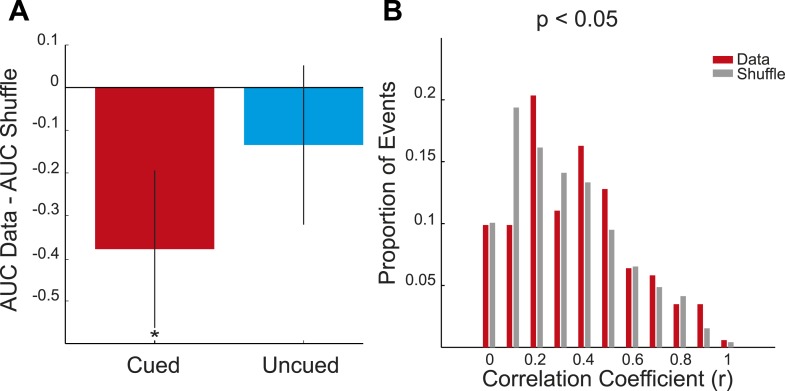
Preplay of cued arm during GOAL-CUE—distribution-based analysis A mean difference between the cumulative distributions of absolute correlations for the bootstrapped data and shuffle for the cued and uncued arms during GOAL-CUE.If a place cell template is preplayed then AUC of the data distribution should be smaller than that of the shuffled distribution (i.e., negative difference score). To assess significance we computed 95% confidence intervals for the difference scores. If the confidence interval did not contain 0 we deemed the data distribution to be significantly different from the shuffle distribution. The distribution for the cued arm was found to be significantly different from the shuffle (p = 0.02), yet that of the uncued arm was not (uncued p = 0.24). Black lines on bars show one standard deviation, * < 0.05. (B) Frequency distribution of absolute correlation coefficients between spiking events and future cued arm templates. Red bars represent data and the grey bars the shuffle distribution. p-value above histogram is based on a two-sample Kolmogorov–Smirnov test comparing the data distribution to the shuffle distribution.